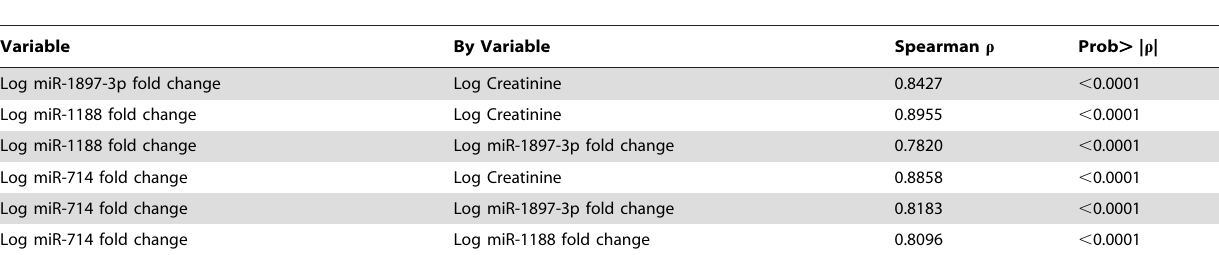
Table 3. Correlation of plasma miR-1897-3p, miR-1188, and miR-714 with plasma creatinine.